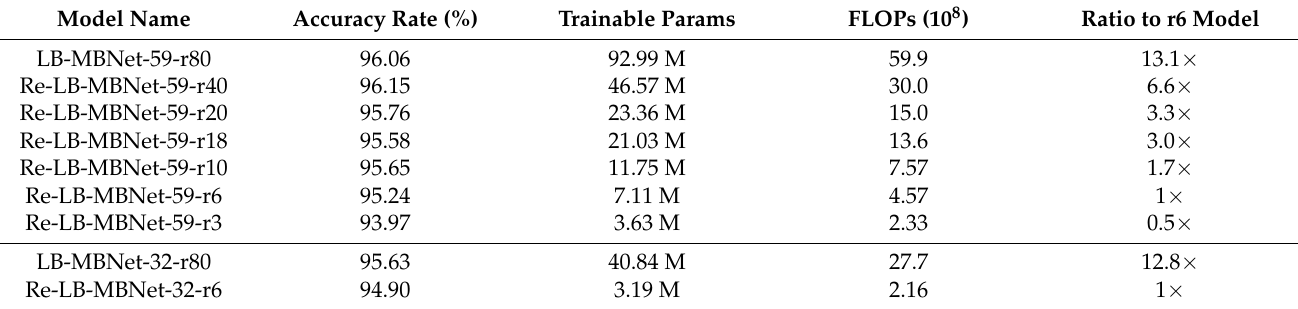
Table 3. Model recognition result with rebuilt model from r80